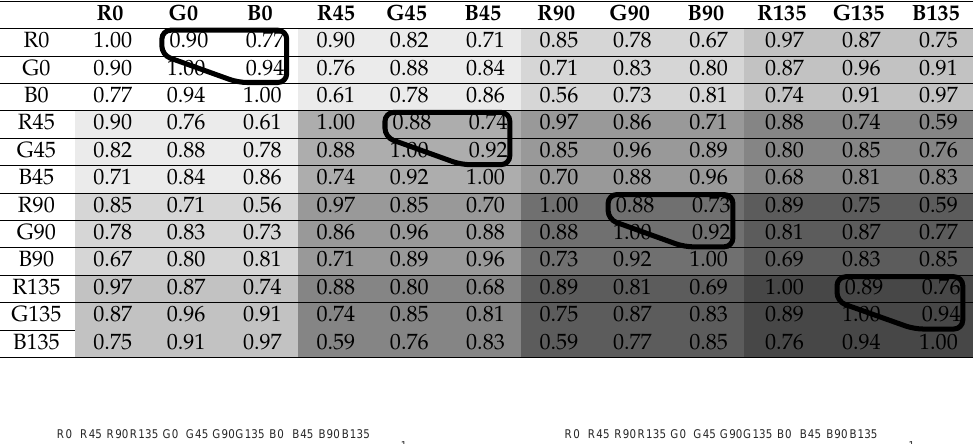
Table 4. Correlation results for Total Object scenario, over all of the 12 channels grouped by polariza- tion channel. Polarization channels are grouped with different grayscale values. The spectral groups of correlation coefficients (surrounded) are passed to the Mann–Whitney U (MWU) computation. Channel groups are distinguished by different colors.